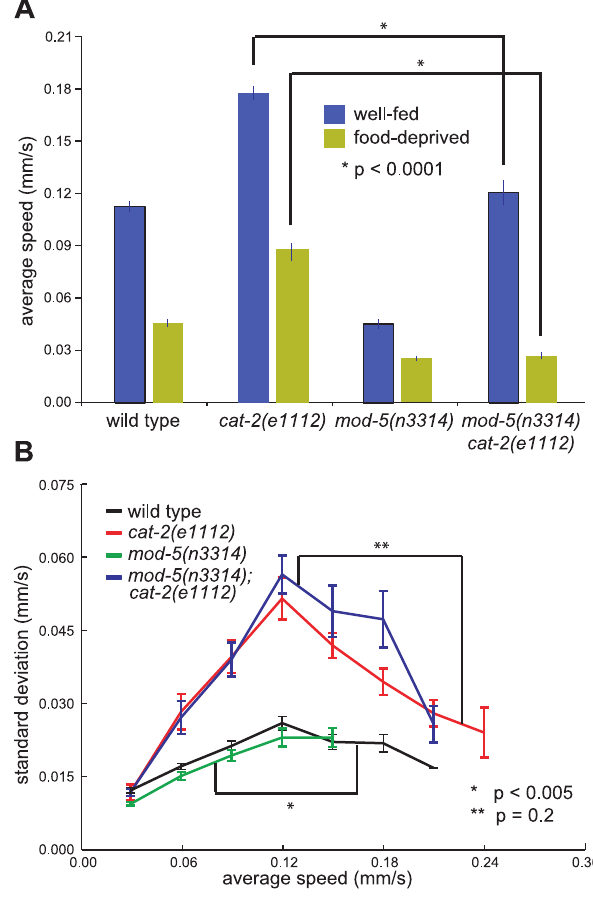
Figure 5. Mutation of mod-5 suppresses the hyperactivity but not the large speed fluctuations of cat-2 mutants. (A) Average speeds of wild-type and mutant animals tested in the well-fed on- bacteria and food-deprived on-bacteria conditions. (B) The average standard deviations of speed measurements within individual tracks for animals on a bacterial lawn. p-values for difference in average speeds were calculated using Student’s T-test. p-values for differences between standard deviation curves for each genotype were calculated using two-way ANOVA. Tracks were first grouped by average speed. Error bars, SEMs. (A: wild-type n=120 well-fed, 109 food-deprived tracks; cat- 2(e1112) n=123, 96; mod-5(n3314) n=58, 53; mod-5(n3314) cat-2(e1112) n=83, 51; B: wild-type n=233 tracks; cat-2(e1112) n=131; mod- 5(n3314) n=219; mod-5(n3314) cat-2(e1112) n=90, all tracks . 30 sec) doi:10.1371/journal.pone.0038649.g005 Mutation of the D1-like DA receptor dop-1(vs100) suppresses the defect in food-dependent slowing associated with the dop-3(vs106) mutation [21]. By contrast, we found that the dop-1(vs100) mutation did not suppress the increased fluctuations in the speed associated with the dop-3(vs106) mutation (Figure 7A).